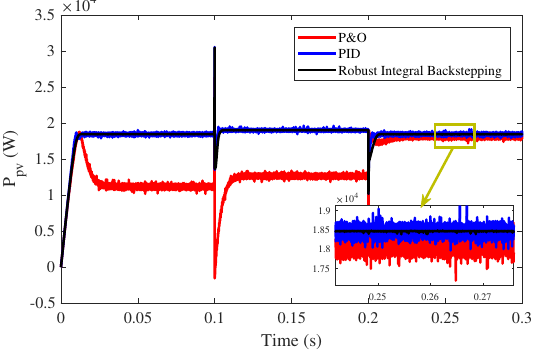
Figure 26. Output power of PV array under varying irradiance and varying temperature.